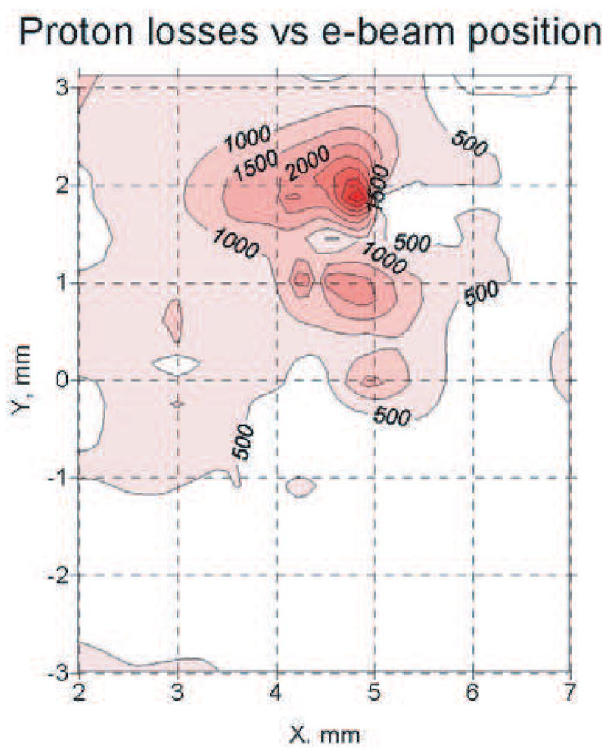
FIG. 85. (Color) Proton losses versus TEL position (Shiltsev) [99].